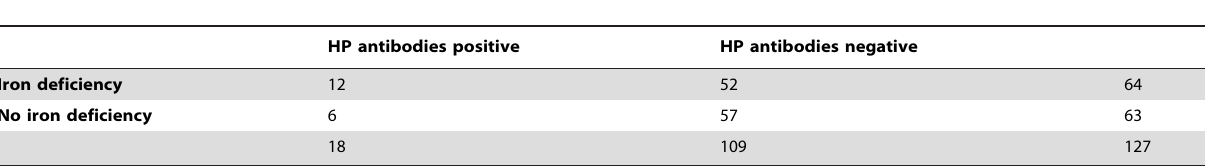
Table 2. The distribution of the study population related to Helicobacter pylori (HP) antibodies and iron deficiency.